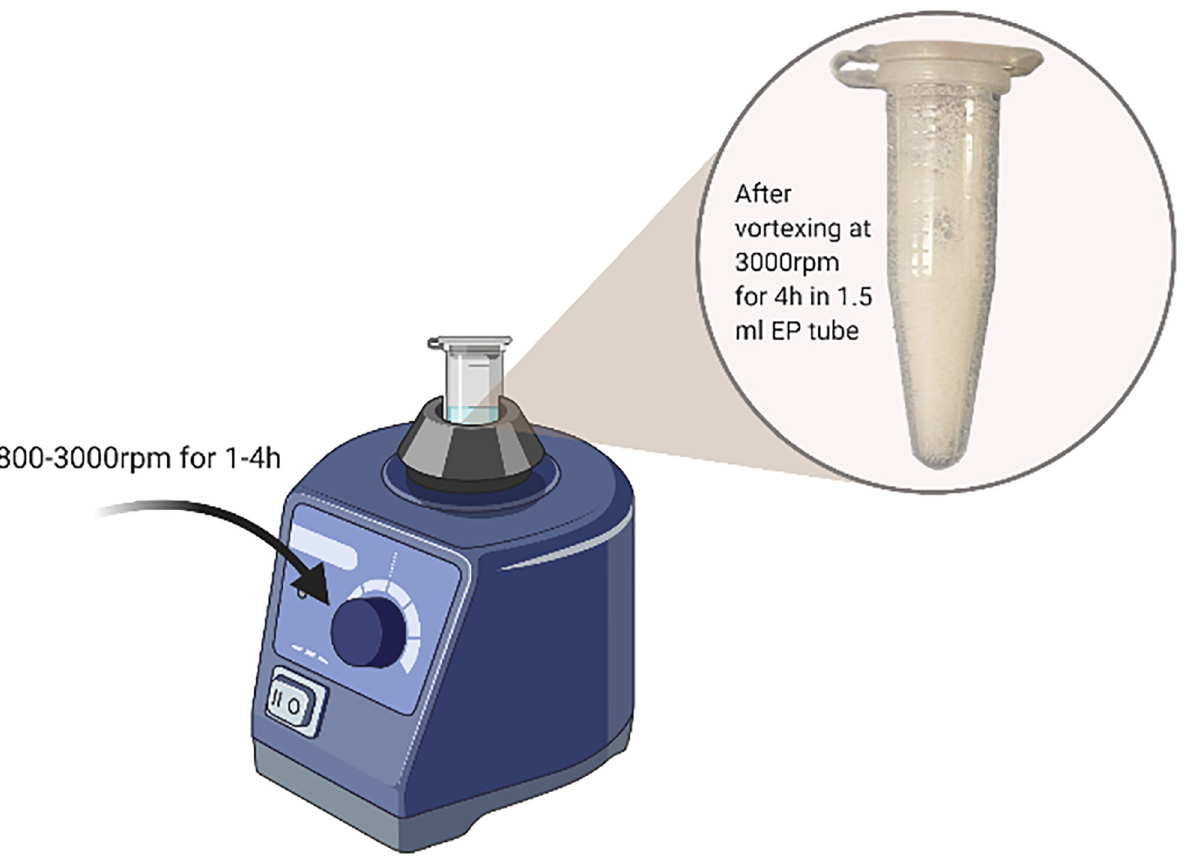
Fig 4. Schematic of forced vortexing experiment used in validating the analysis